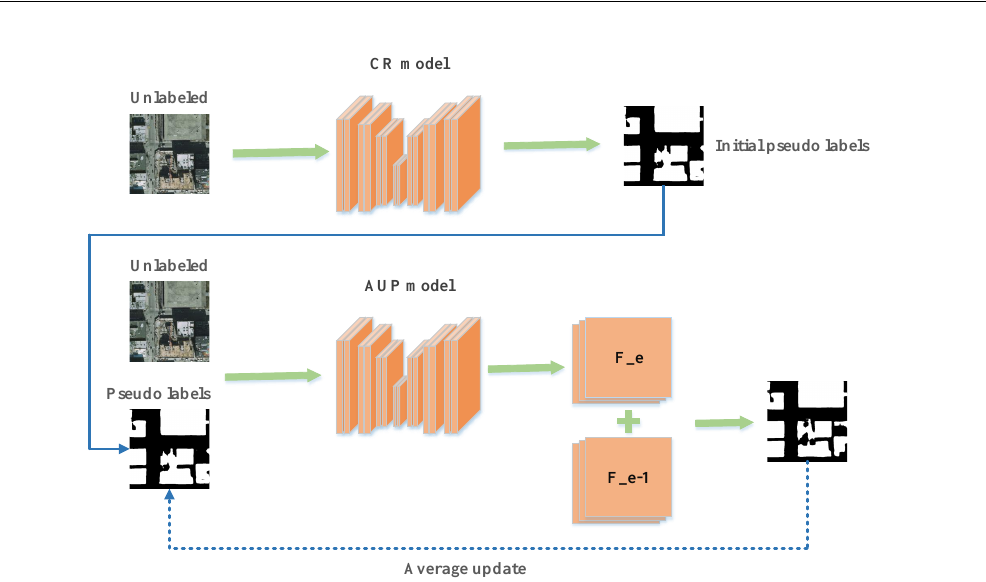
Figure 2. The main framework of our proposed average update of pseudo-label (AUP) method. We first obtain initial pseudo labels with the consistency regularization (CR) trained model, and then continue to train the model by updating feature maps and generate better pseudo labels after each